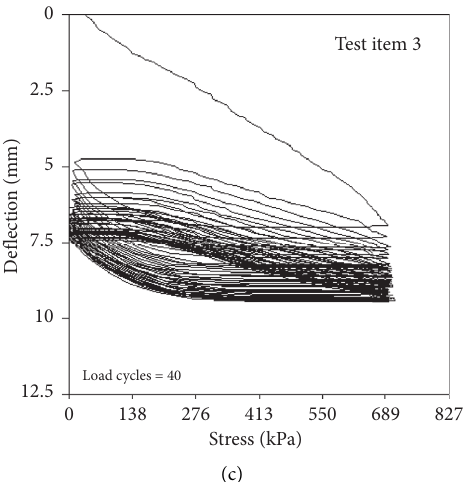
Figure 7: Cyclic plate load test results. (a) Test item 1: 200mm of HFA. (b) Test item 2:200mm of HFA stabilized with the geogrid (7-day cure). (c) Test item 3: 200mm of HFA (28-day cure).